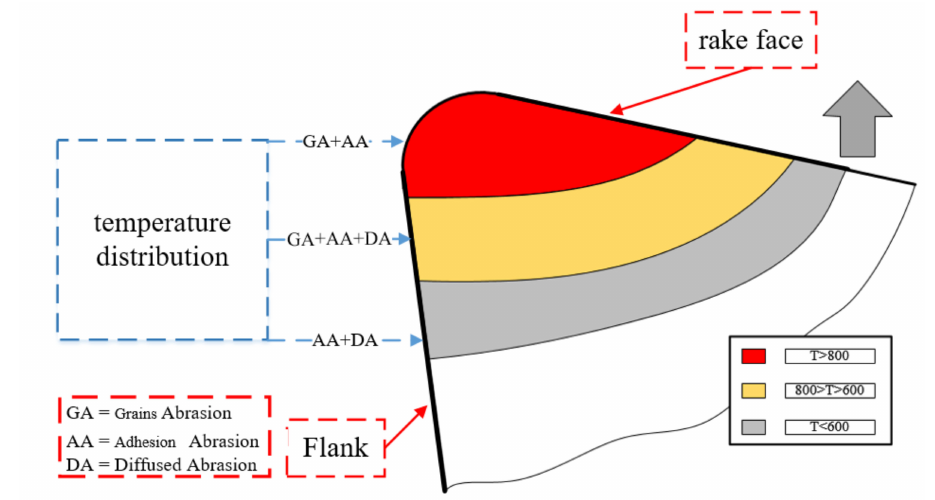
Figure 8. Schematic diagram of tool abrasion type at di ff erent